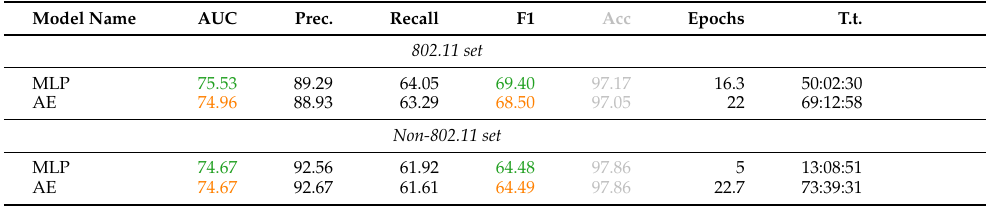
Table 6. Results for DNN models. Best and worse AUC and F1 scores are shown in green or orange text,